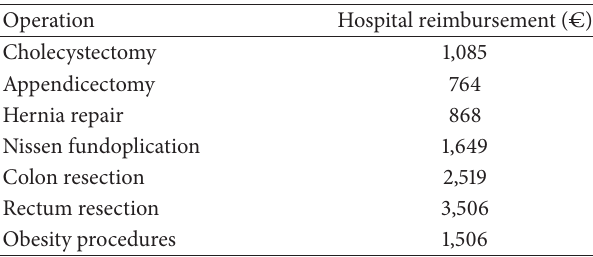
Table 3: Hospital reimbursements by social security funds for common, uncomplicated laparoscopic